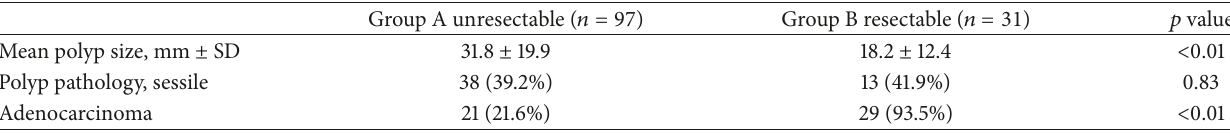
Table 2: Comparison of resectable and unresectable polyps in patients undergoing eventual colonic segmental resection at St. Paul’s Hospital in Vancouver,